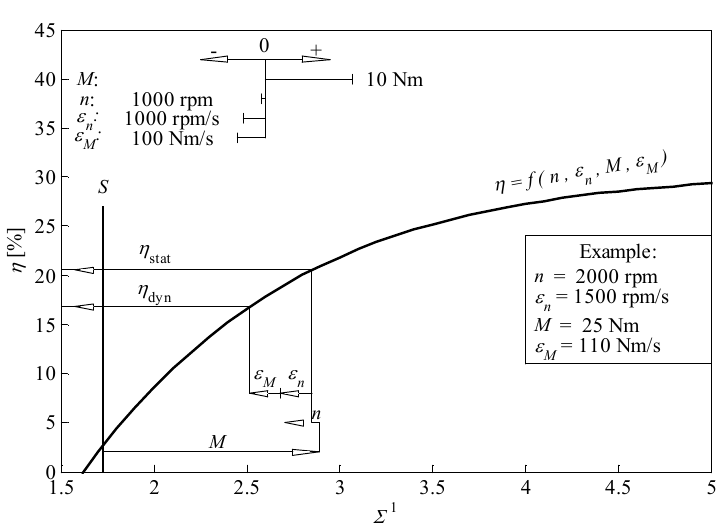
ffi ciency characteristic.